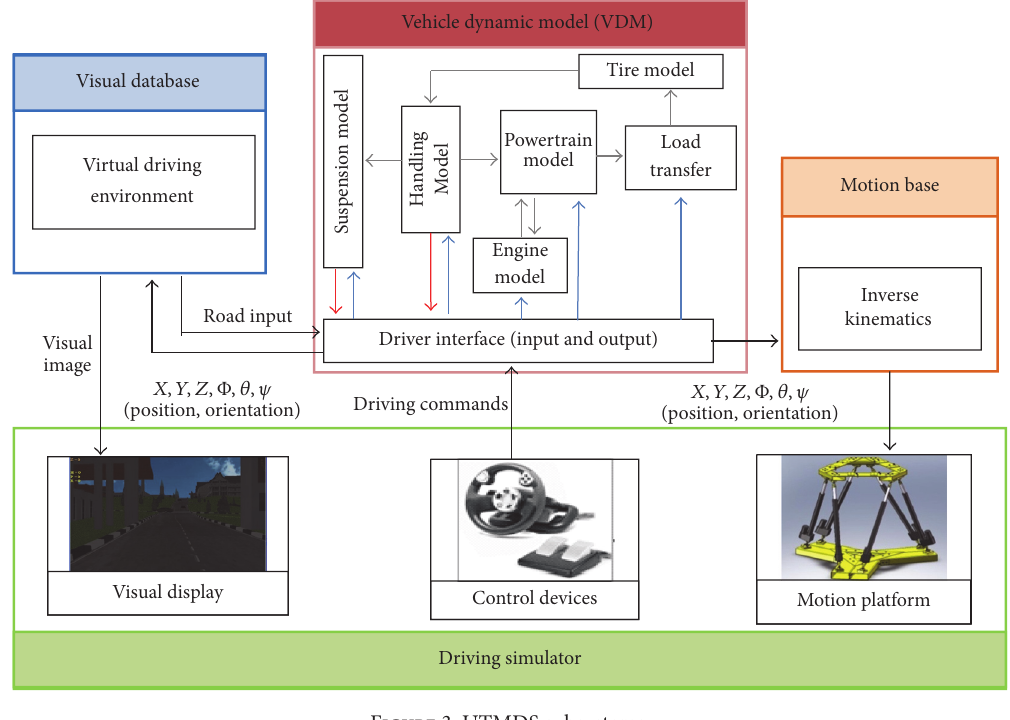
Figure 3: UTMDS subsystems.